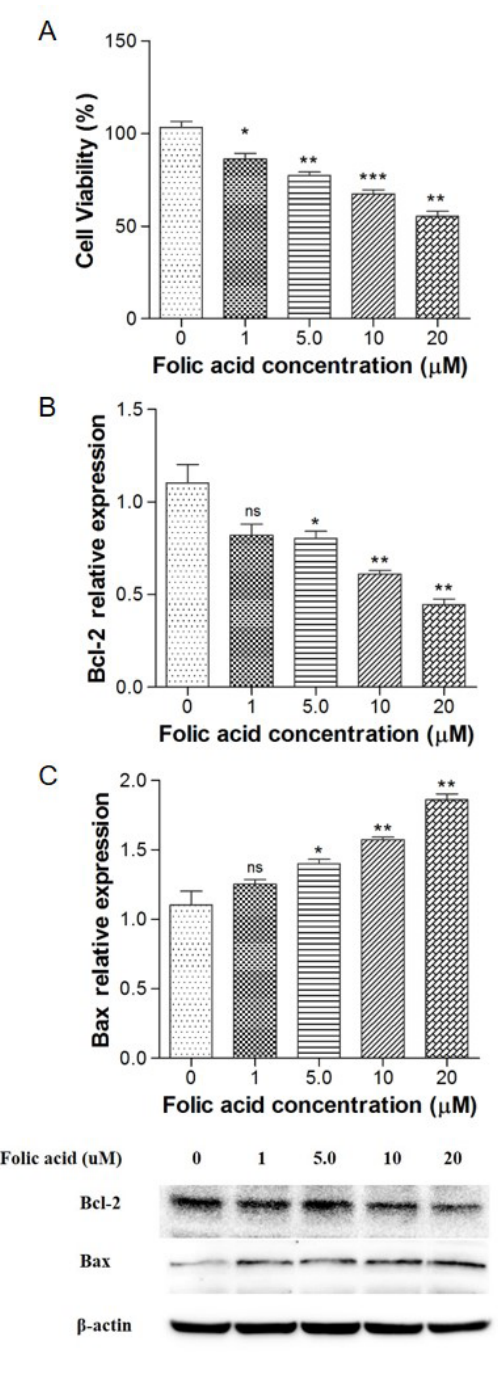
Figure 1: Folic Acid treatment can inhibit the proliferation of MDA- MB-231 cells and the expression level of Bcl-2 and up-regulate the expression level of Bax. A)MDA-MB-231 cells were treated with folic acid at different concentrations (0 μM, 1 μM, 5 μM, 10 μM, 20 μM)